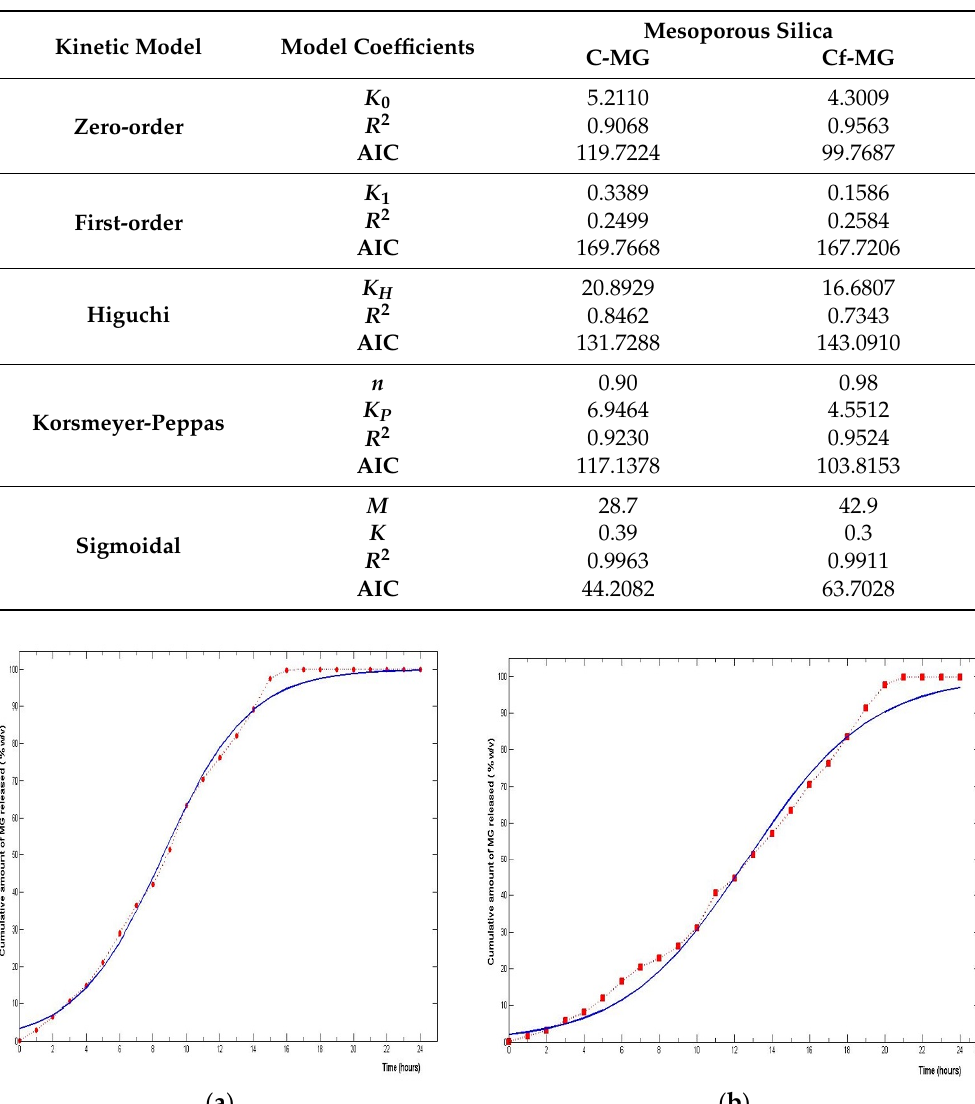
Table 2. Results of curve fitting of the in vitro release profile of magnolol (MG) from mesoporous silica SBA-15.